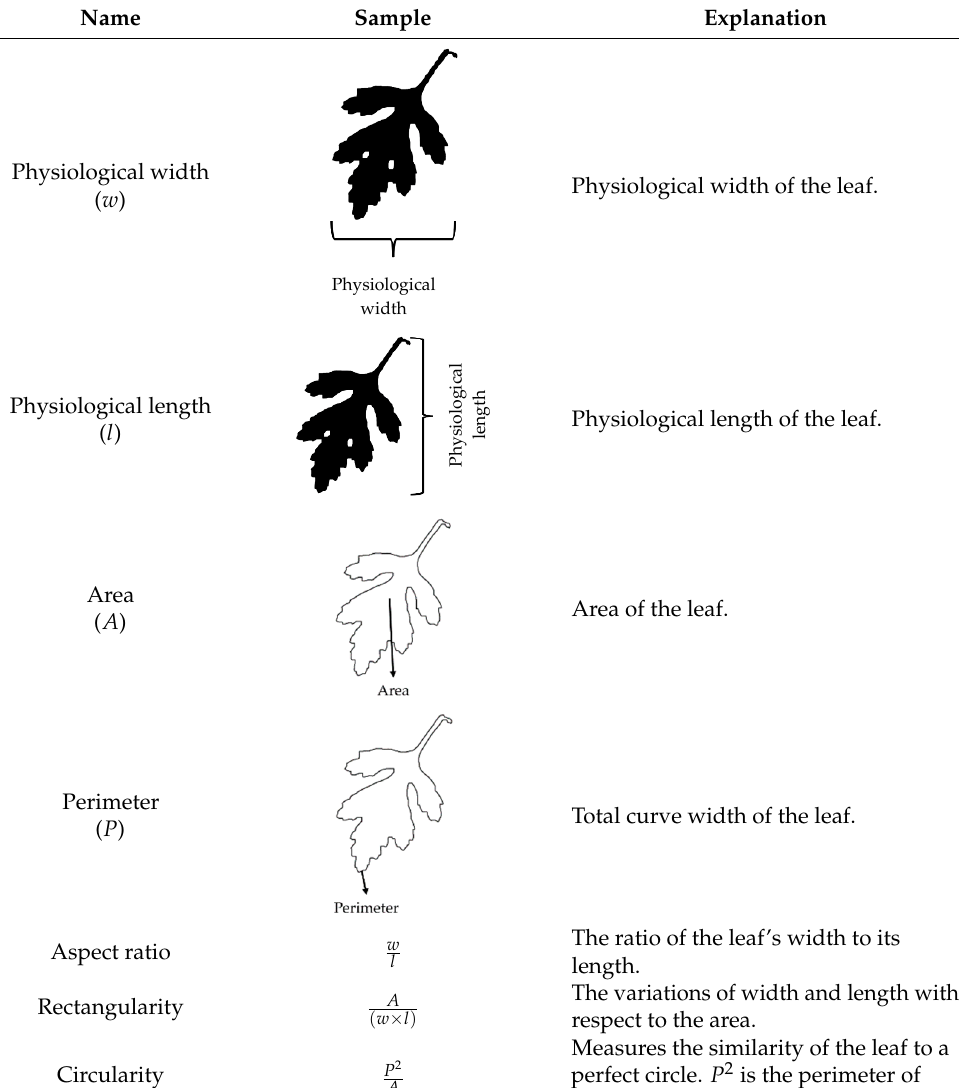
Table 2. Description and explanation for shape features extracted from the dataset.